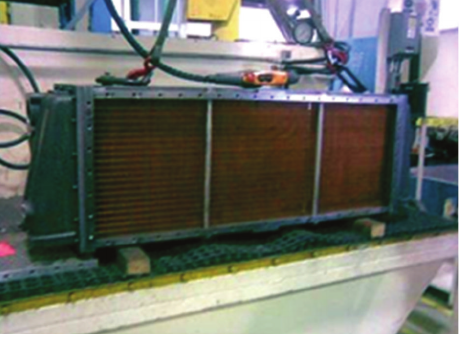
Figure 1: Heat exchanger for heavy duty machinery of copper UNS C10300 and carbon steel G10200.